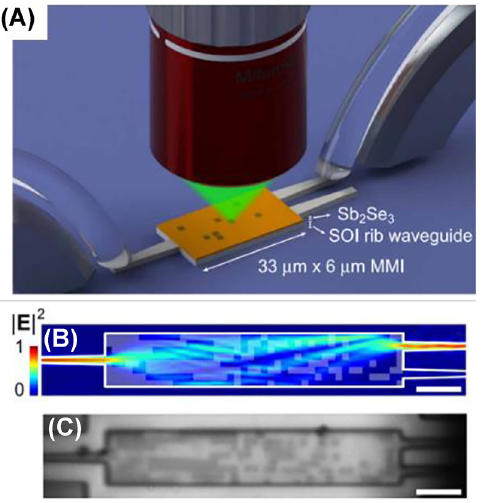
Figure 8: Perspective scheme for individual programming meta-atoms with vertically coupled laser. (A) Schematics of optical writing of patterns on a multimode interference router. (B) Numerically calculated electric field distribution in programmed device. The write area is the outline of the silicon device, and the white transparent patches represent the crystalline Sb amorphous background. (C) Optical microscope image of the laser programmed optical phase change material. Scale bars: 5 μ m [81]. © 2021 The